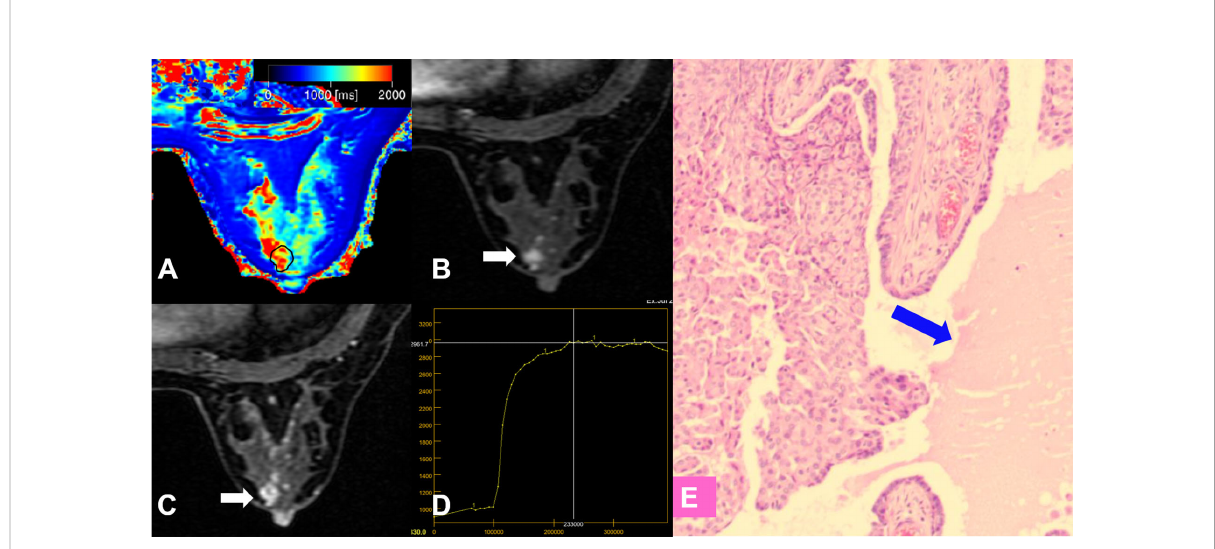
FIGURE 6 False-positive lesion identi fi ed by the KS. (A – E) A 45-year-old female patient: MRI showed a mass lesion in the right breast [ (B, C) , white arrow]. The lesion showed no root sign, irregular margins (B, C) , and a plateau enhancement curve type (D) . (A) T1 map, (B) Early contrast-enhanced MRI, (C) Delayed contrast-enhanced MRI, (D) TIC curve, (E) Pathological image (H&E, 100×): an area of edema was seen within the lesion (blue arrow). The Kaiser score was 5 and was classi fi ed as positive for malignancy. The T1 relaxation time was 1711.24 ms, which was higher than the cutoff value of 1595.94 ms. The combined diagnosis using the KS and T1 value identi fi ed a benign lesion. Histopathology revealed a papilloma (E) .